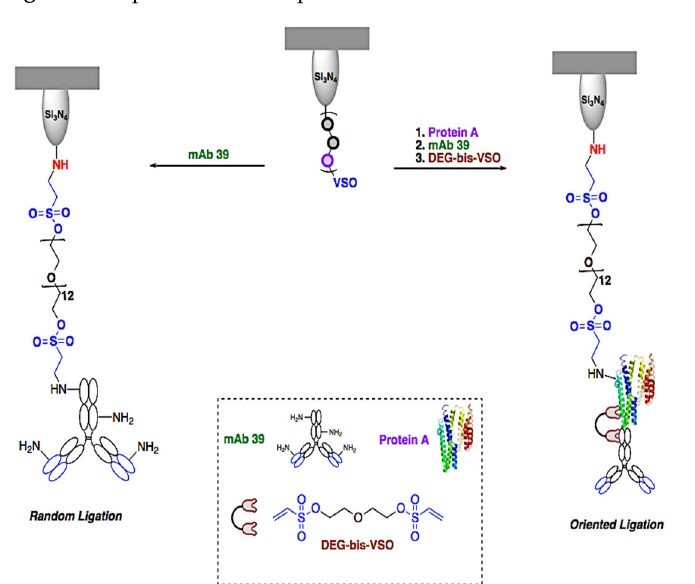
Figure 2. Random and oriented ligation of anti-TS mAb 39 antibody to PEG-VSO functionalized tips.